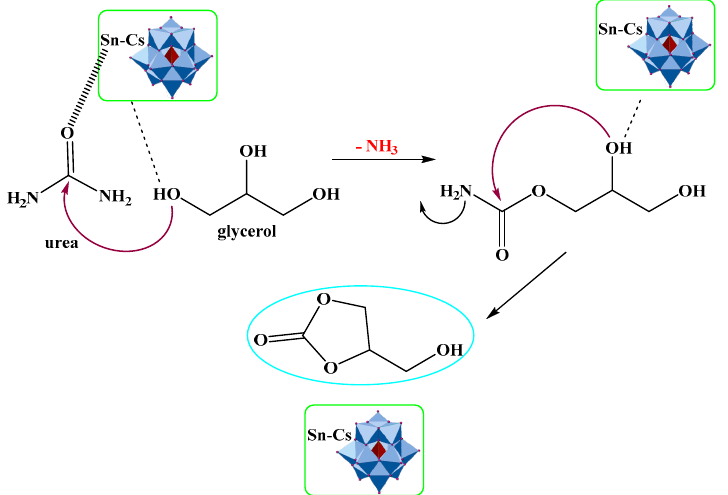
Figure 32. Main products of glycerol carbonation with urea over Cs 3 PW 12 O 40 /SnO catalyst (adapted from ref. [75]).